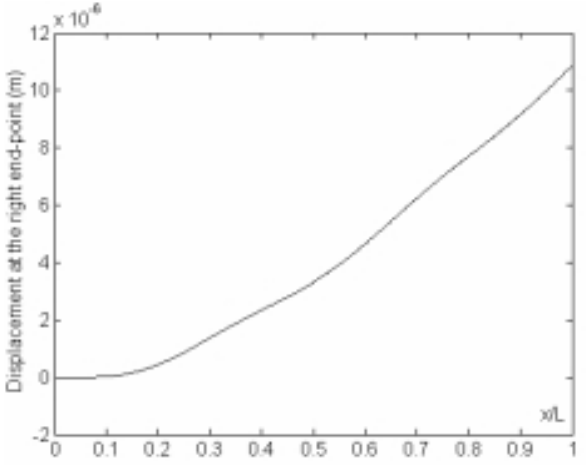
Fig. 7. Displacement at the right end-point of a fixed-free beam with β = 0 . 15 under a moving force with v = 50